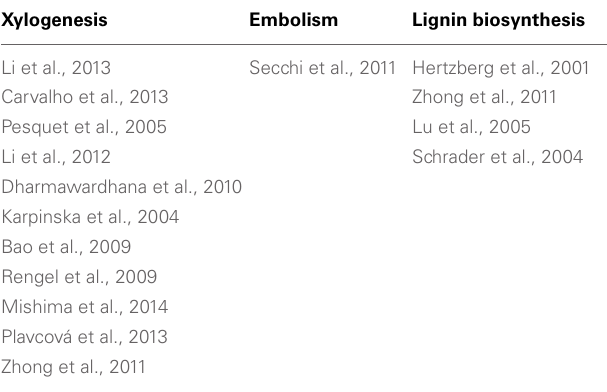
Table 3 | Some representative transcription factors in Populus Table 4 | Representative transcriptome studies in